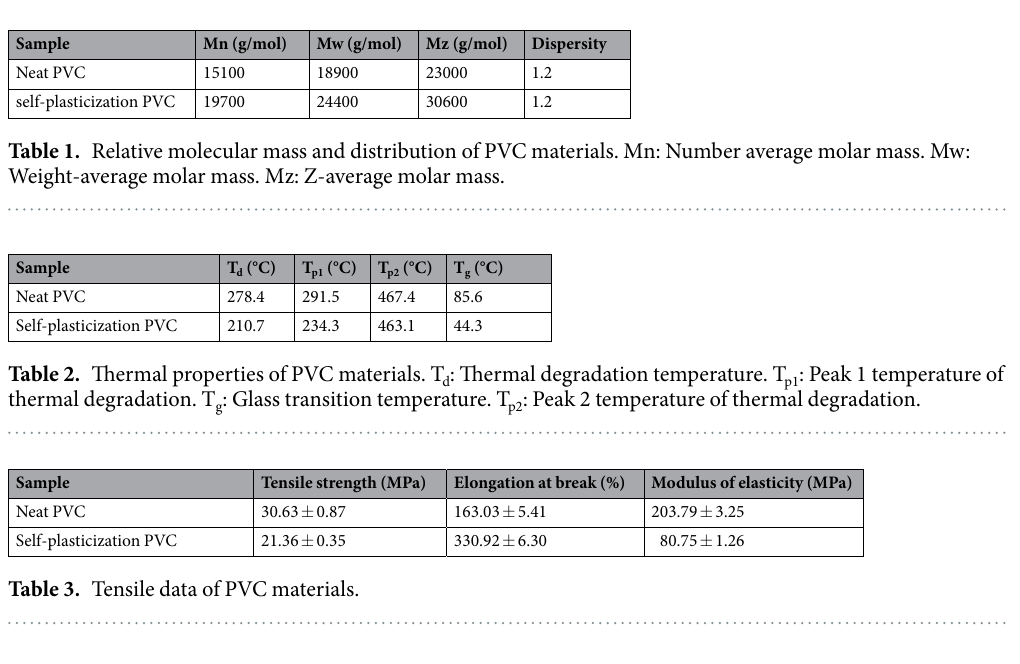
Figure 5. ( a ) GPC spectra of neat PVC and self-plasticization PVC; ( b ) TGA curves of neat PVC and self- plasticization PVC; ( c ) DTG curves of neat PVC and self-plasticization PVC; ( d ) DSC curves of neat PVC and self-plasticization PVC.